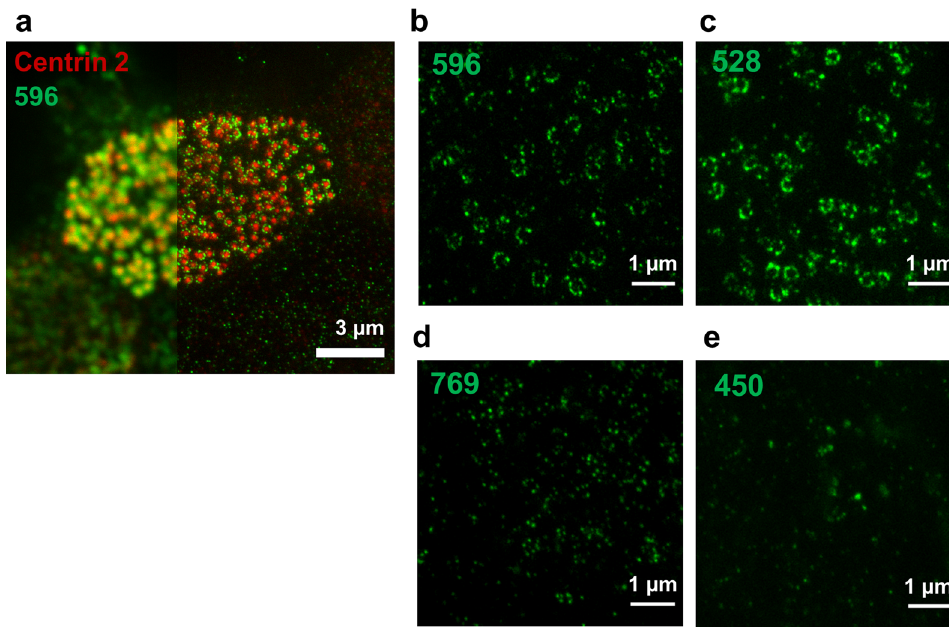
Figure 3. Super-resolution microscopy of 596 immunofluorescence reveals ring-like pattern at the bases of cilia. ( a ) Representative image of the apical side of a non-CF HBE cell co-immunostained with 596 and centrin-2 antibody; left side: confocal image, right side: super-resolution STED image. ( b–e ) Representative STED images of apical membrane fluorescence in HBE cells obtained using 596, 528, 796 and 450